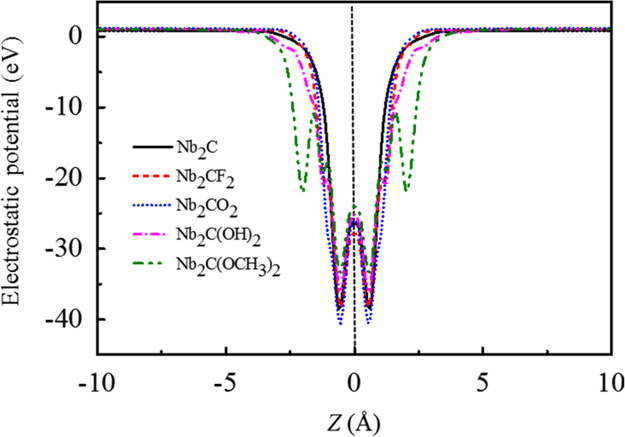
Planar averaged electrostatic potentials along the z-direction of Nb2C and Nb2CZ2 (Z = F, O, OH, OCH3). The peaks in green circles are enlarged to be more clearly.